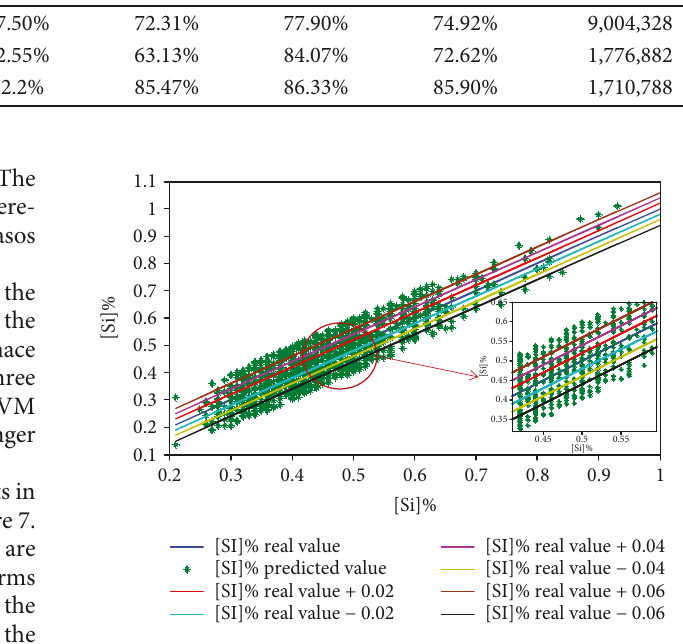
Figure 7: Fluctuation of dynamic loading results in di ff erent regions of true